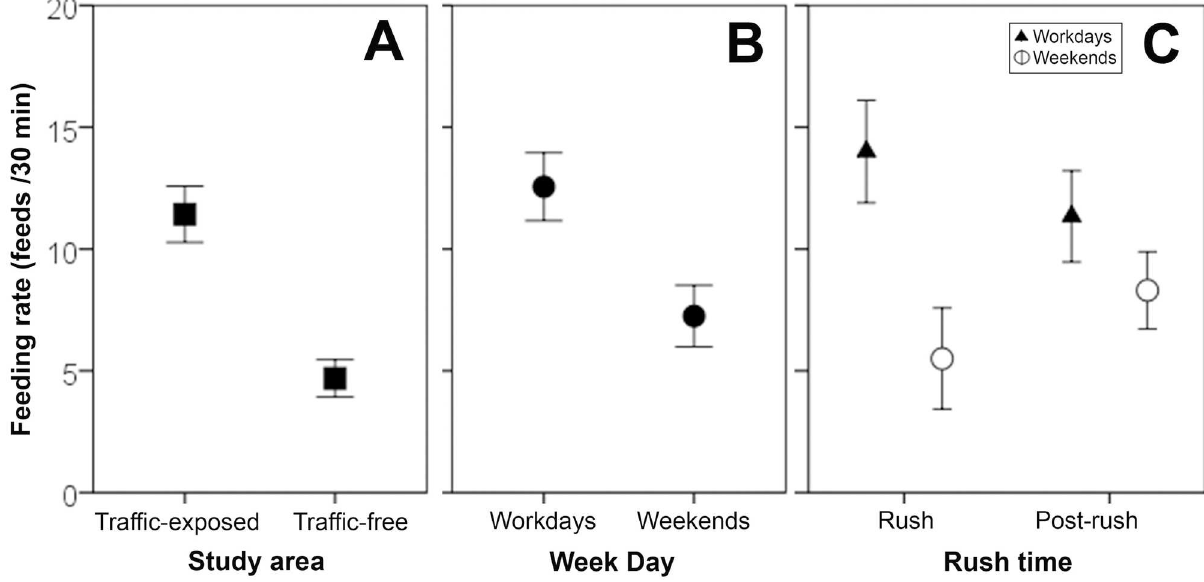
Fig 2. Spatio-temporal variability in feeding rates (feeds/30min). (A) Data from traffic-exposed and traffic-free colonies.Feeding rates across week days (B) and accordingto rush time (C) correspondto traffic-exposed colonies. Bars represent means ± SE.